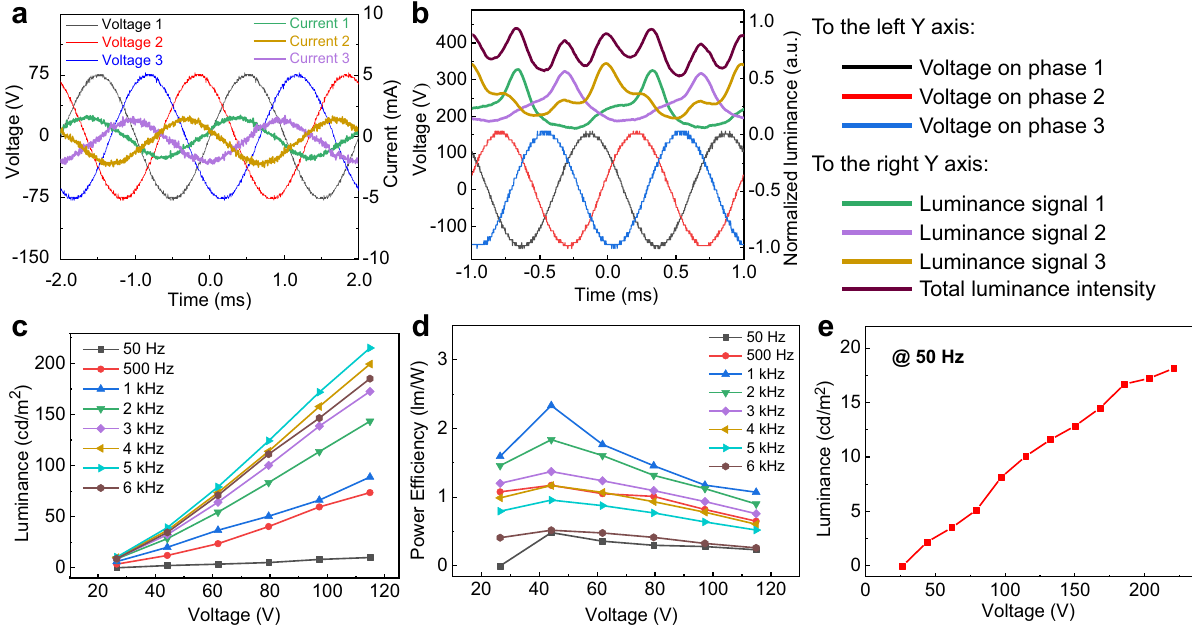
Fig. 2 Characterization of TPEL devices. a Oscilloscope signals of the three-phase voltage at V rms = 53 V, 500 Hz and corresponding three-phase current oscillograms. b Relationship between the periods of three-phase driving voltage ( V rms = 106 V, 1000 Hz) and the light output for each phase and the total light output intensity for standard TPEL device using DI water as a polar bridge. Luminance ( c ) and power ef fi ciency ( d ) of the TPEL device at different applied frequencies as a function of applied voltage. e Dependence of luminescence on applied AC voltage of 50 Hz frequency, showing that our TPEL devices can be driven directly by mainstream power supply system of 110/220 V, 50/60 Hz. All the above measurements were conducted using a TPEL device (3 × 2 cm) with glass-ITO as a substrate/electrodes, commercial phosphor GG65 as an emitter, and DI water as a polar bridge. Source data are provided as a Source Data fi